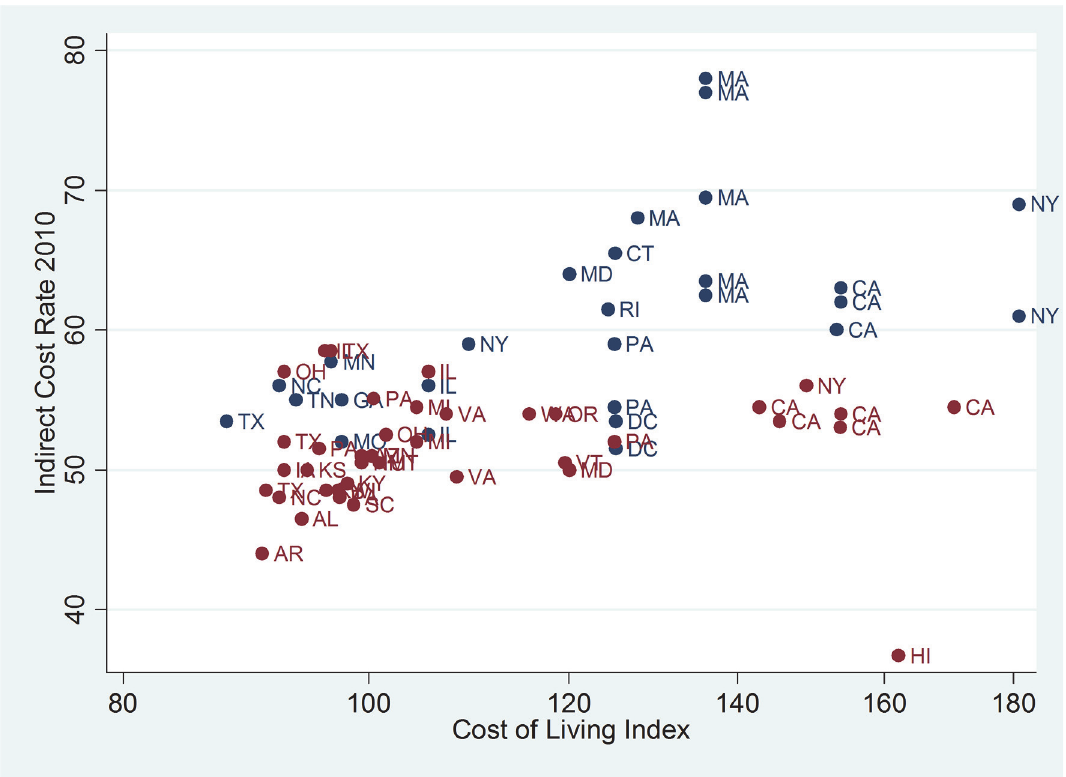
Fig 2. Institutional indirect rates in 2010 by cost of living (ACCRA index). Location of institutions is denoted by standard state abbreviations. Public institutions are shown in red and private institutions are blue.